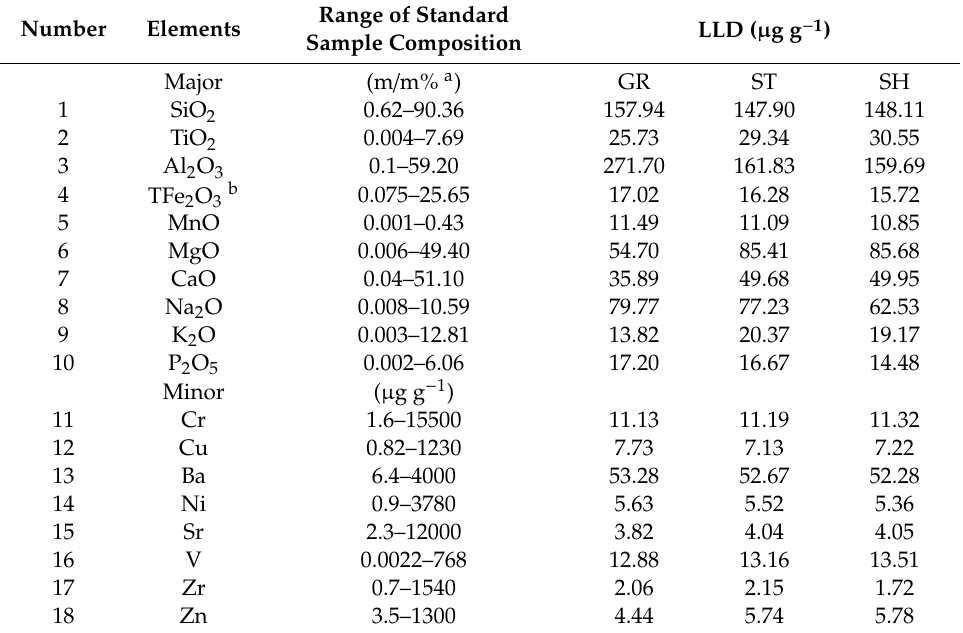
Table 2. Data for the range of standard sample compositions and limits of detection (LLD) of the three sample preparation